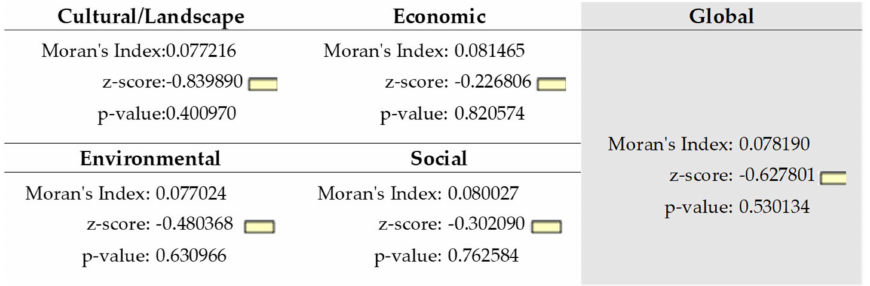
Figure 6. Getis–Ord General G (d) results for the sustainability pillars. Source: authors’ own material from calculations carried out using ArcGIS